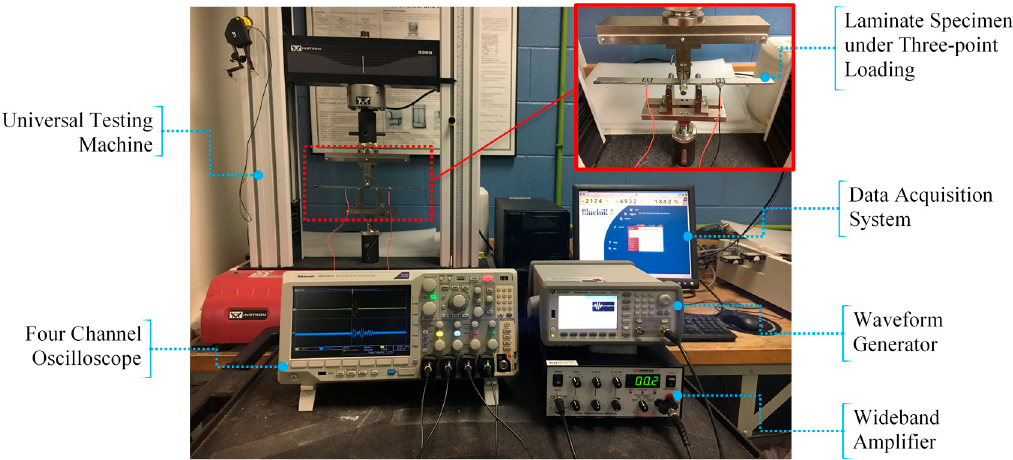
Figure 3. Experimental setup of health monitoring experiment and magnified view of laminate specimen under three-point bending test.